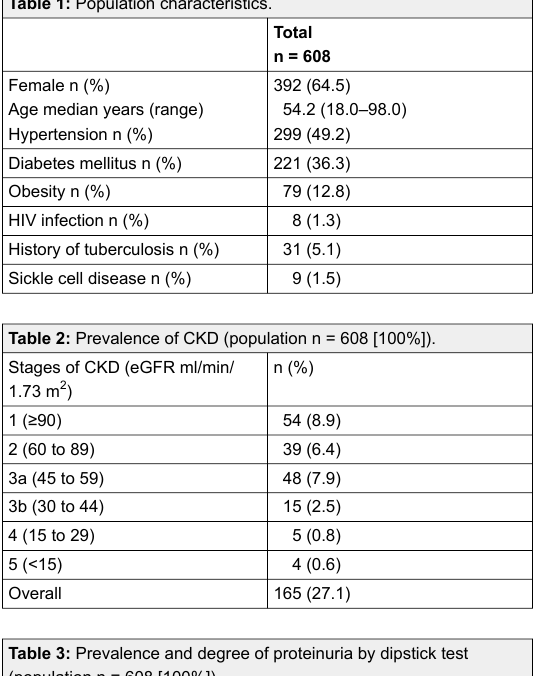
Table 1: Population characteristics.